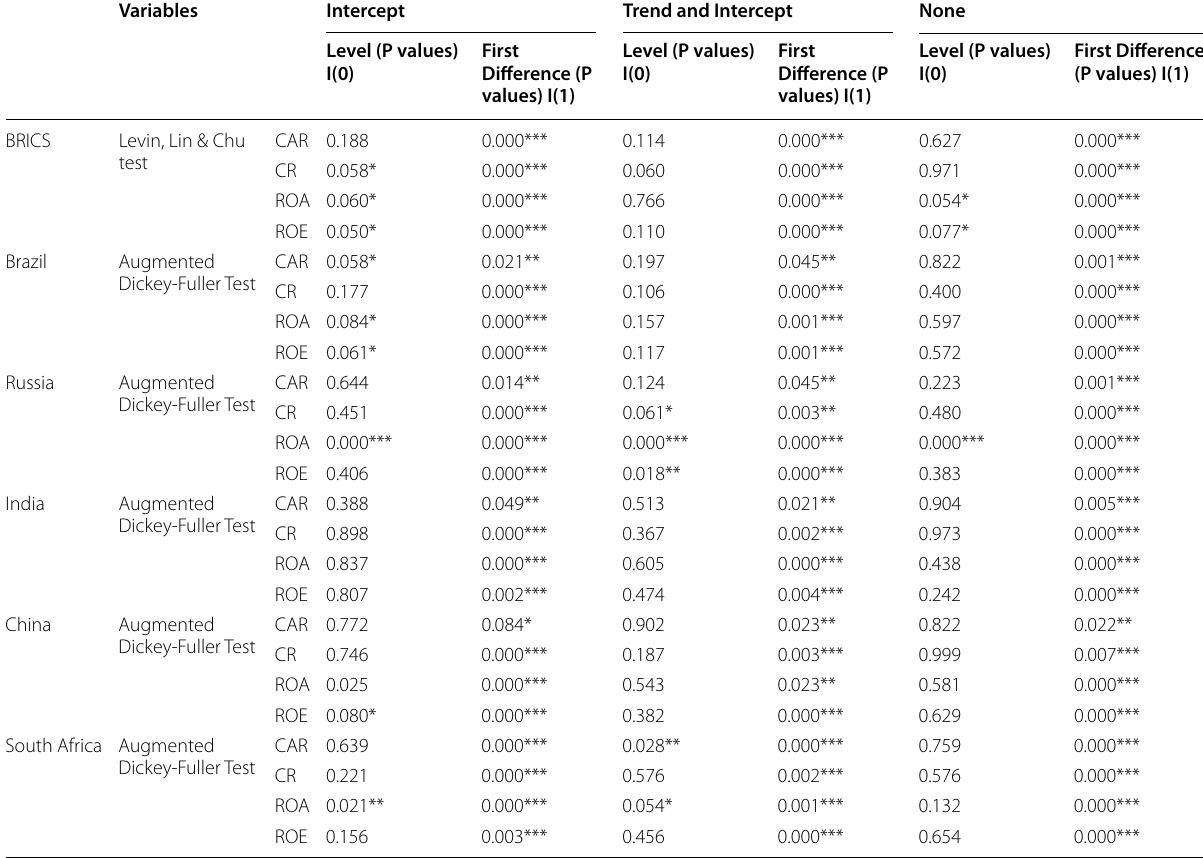
Table 1 Unit root tests results. Source : Authors’ estimations using